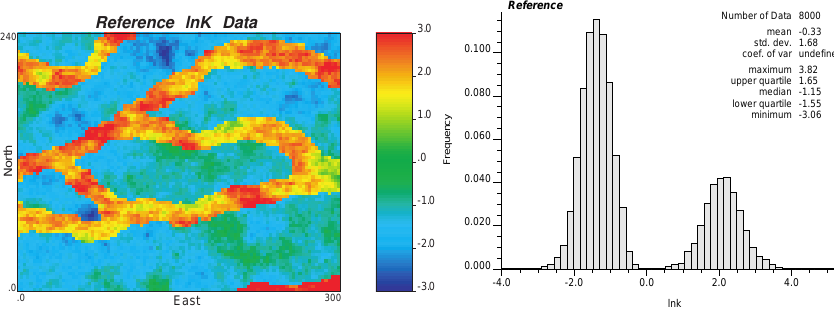
Fig. 2. Reference ln K data.